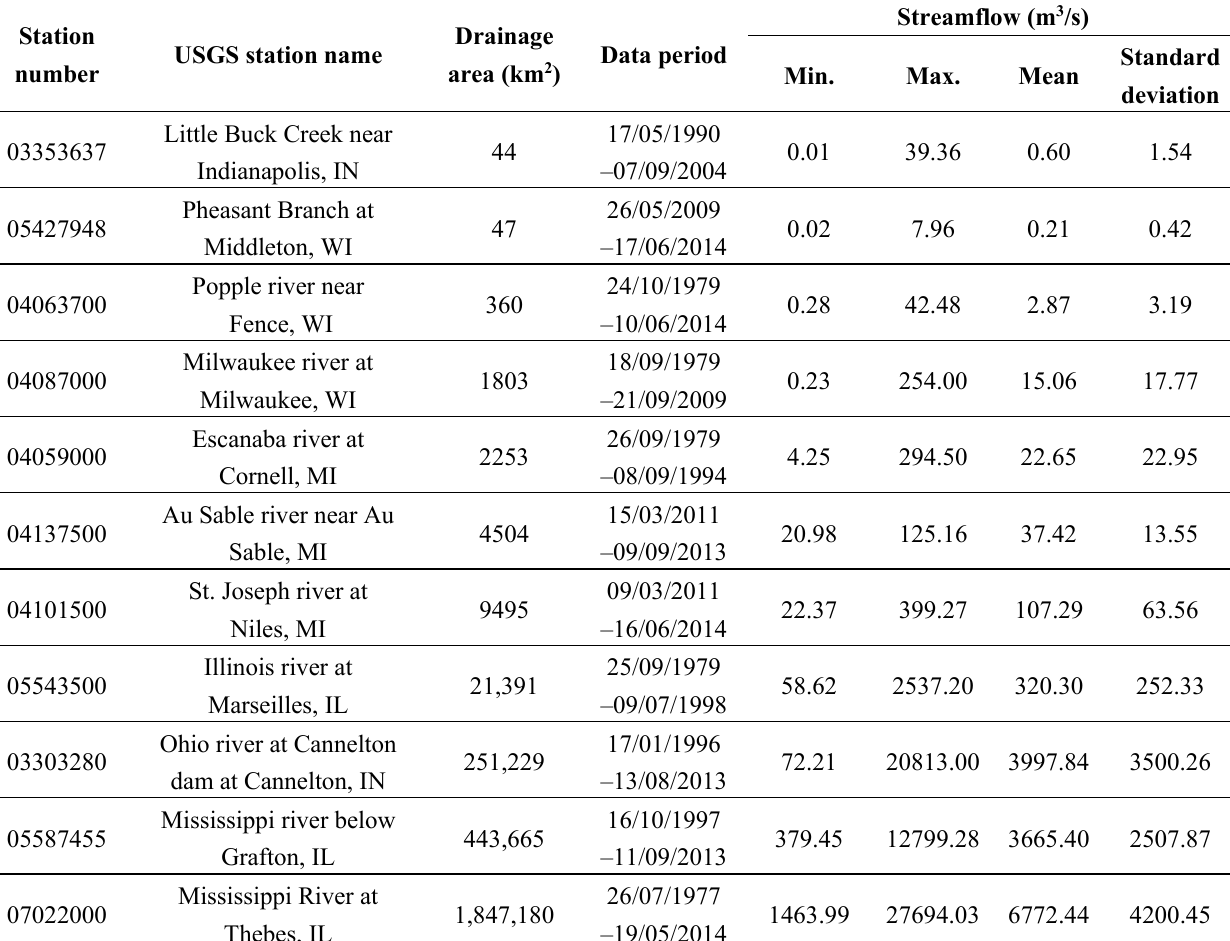
Table 1. USGS locations and streamflow data